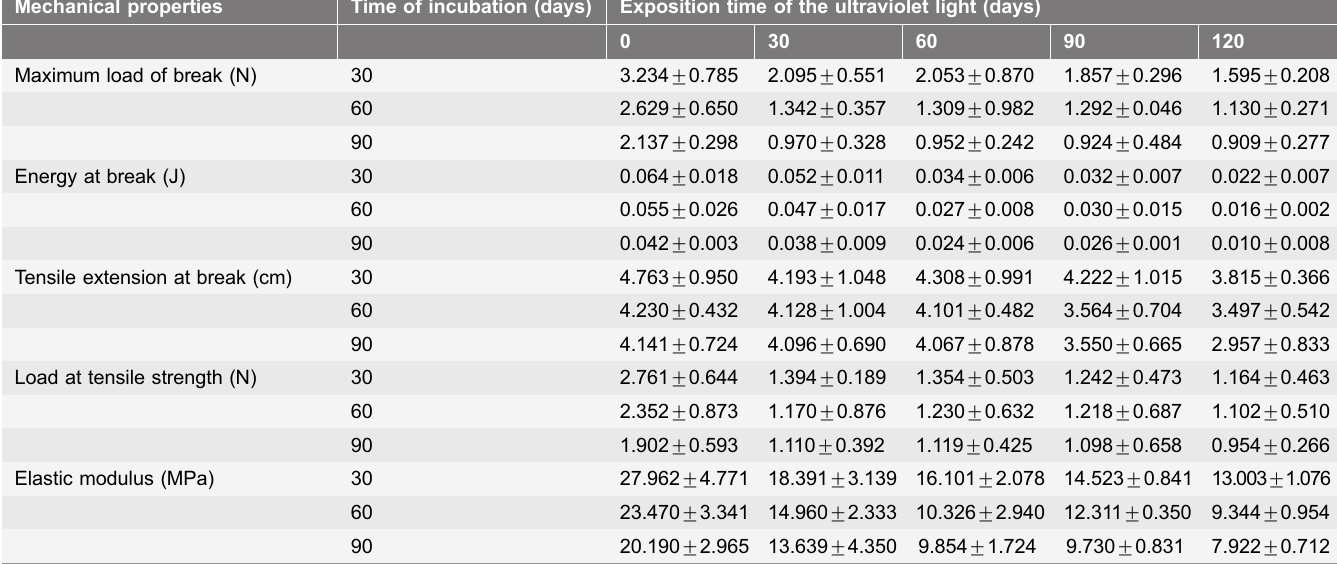
Table 2. Mechanical properties of oxo-biodegradable plastic before and after 30, 60 or 90 days of incubation with Pleurotus ostreatus